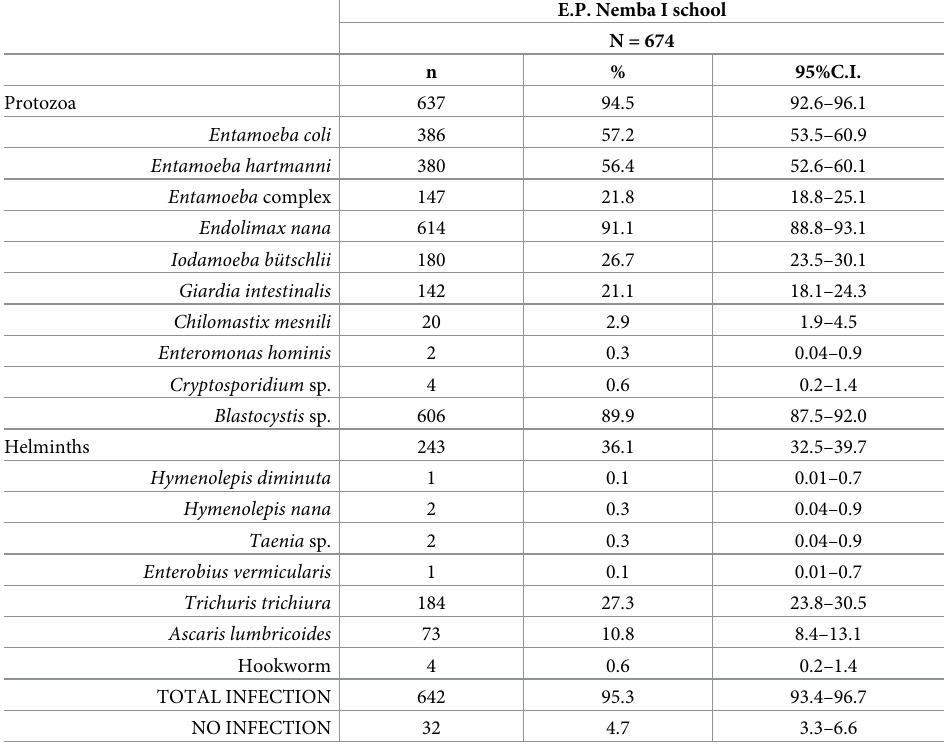
Multiple infection (83.8%) was more prevalent than single infection (16.2%). Three differ- ent species show the highest percentage of co-infection (19.2%) with nine species in two schoolchildren being the maximum number of multiparasitism detected. Multiparasitism of STH species only occurred in 1.1% of the infected schoolchildren, and co-infection by Table 2. Protozoa and helminth infections prevalence.